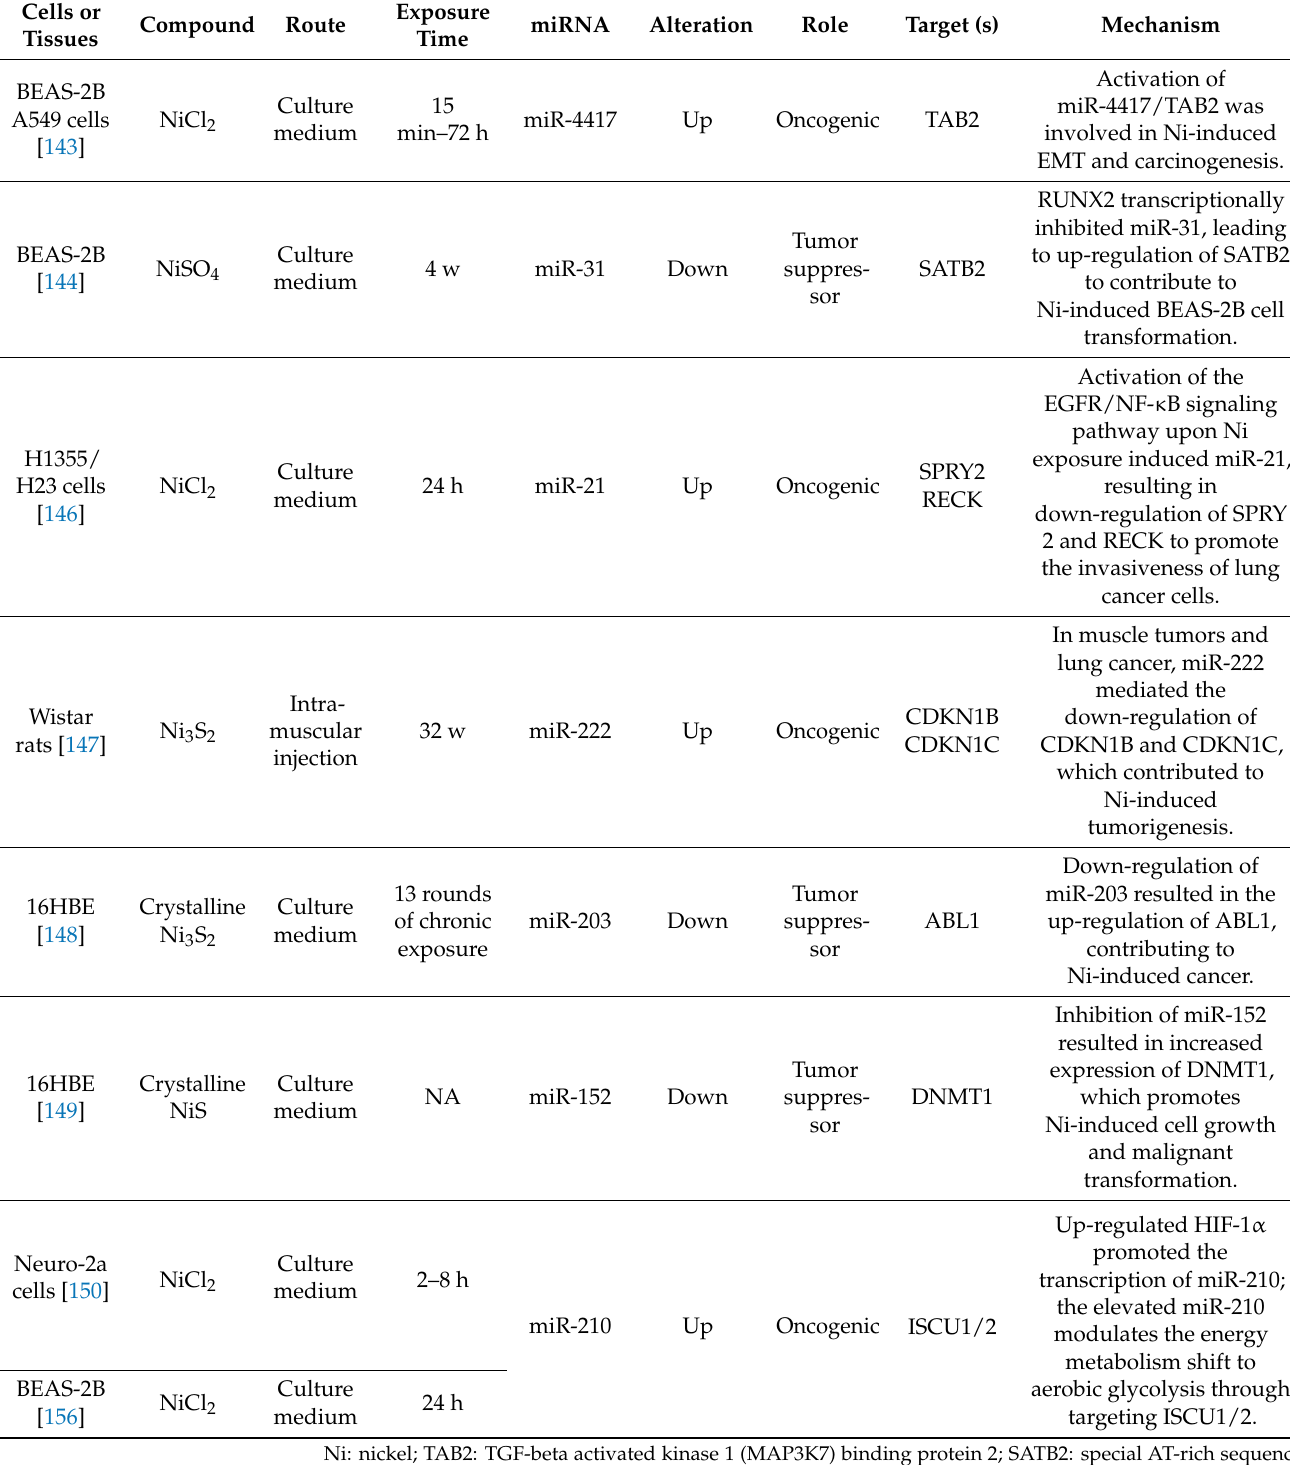
Table 6. Roles of altered miRNA in Ni exposure-induced